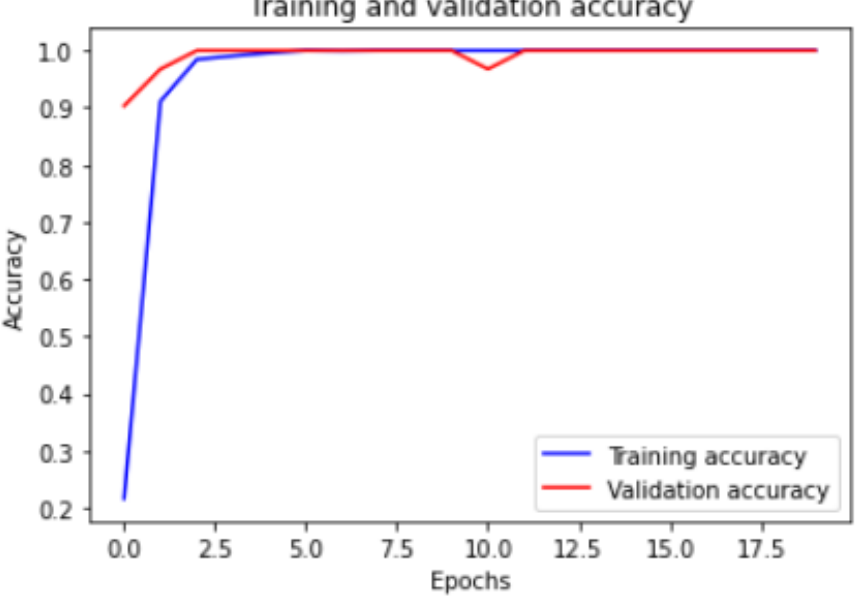
Figure 6. The training and validation accuracy through 20 epochs of the proposed ML-CNN